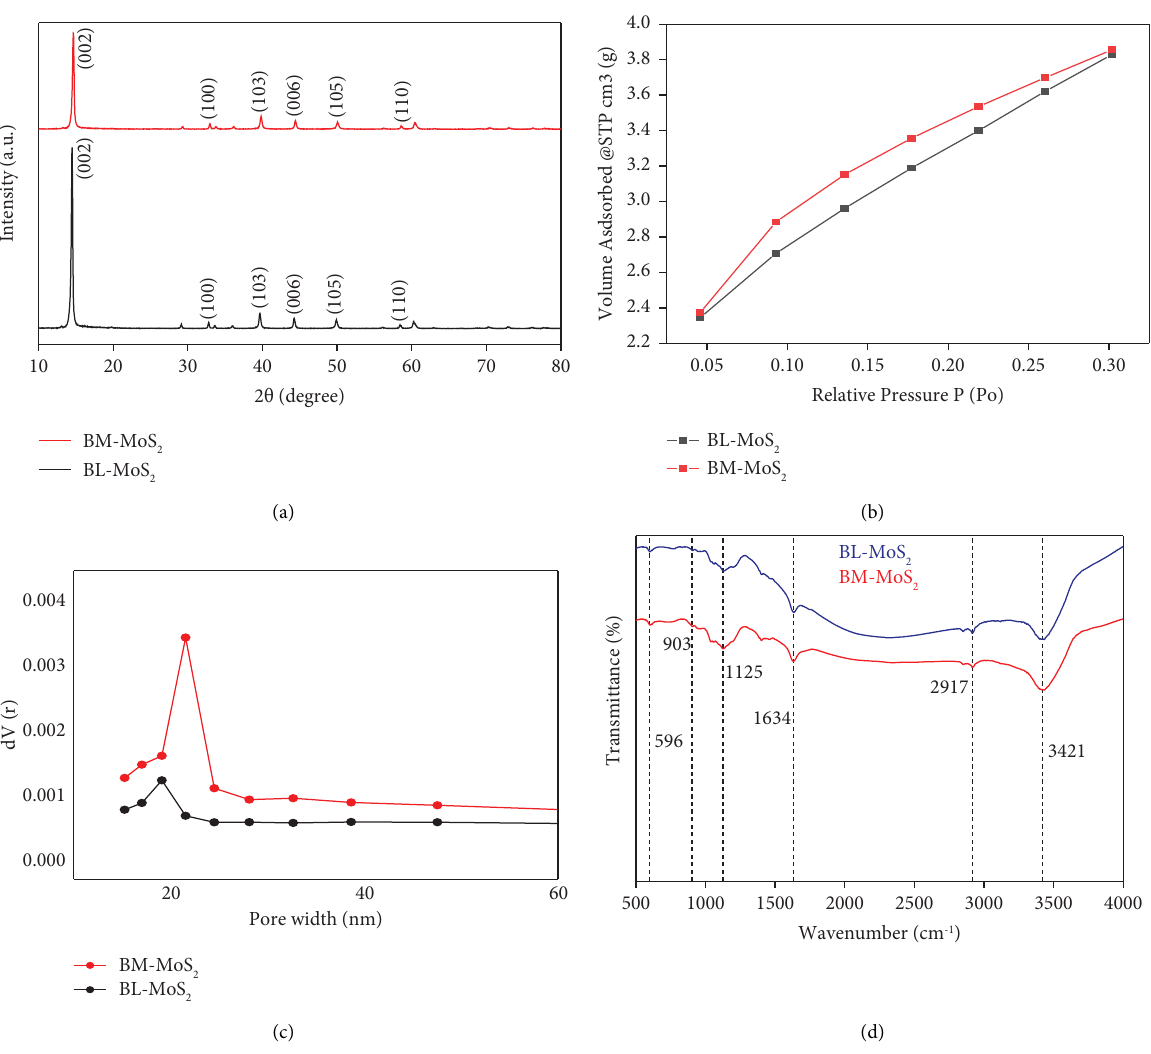
Figure 1: (a) XRD pattern of BL-MoS 2 and BM-MoS 2 . (b) N 2 adsorption-desorption isotherms of BL-MoS 2 and BM-MoS 2 . (c) Pore size distribution. (d) FTIR spectra of BL-MoS 2 and BM-MoS 2 in the range of 400 to 4000cm − 1